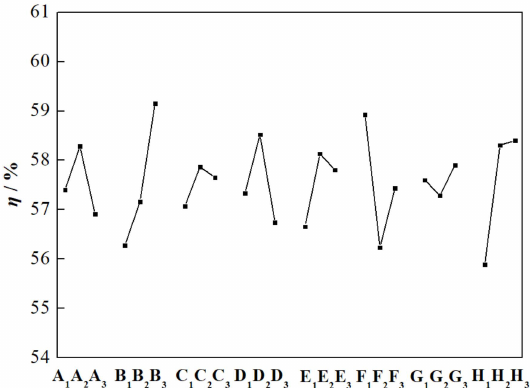
Figure 9. Relation between factor and efficiency.